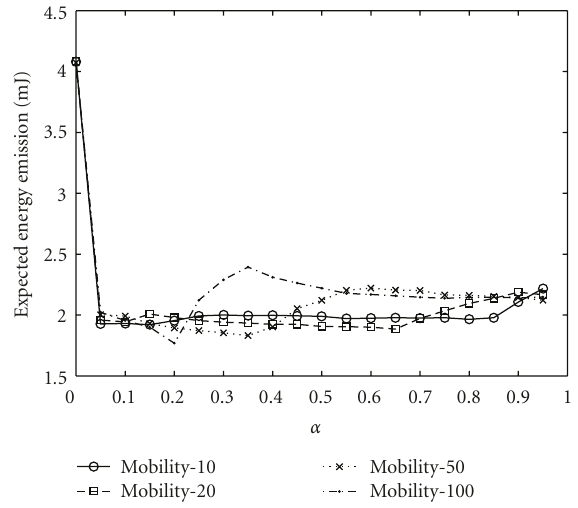
Figure 11: The best alpha value with di ff erent levels of mobility.